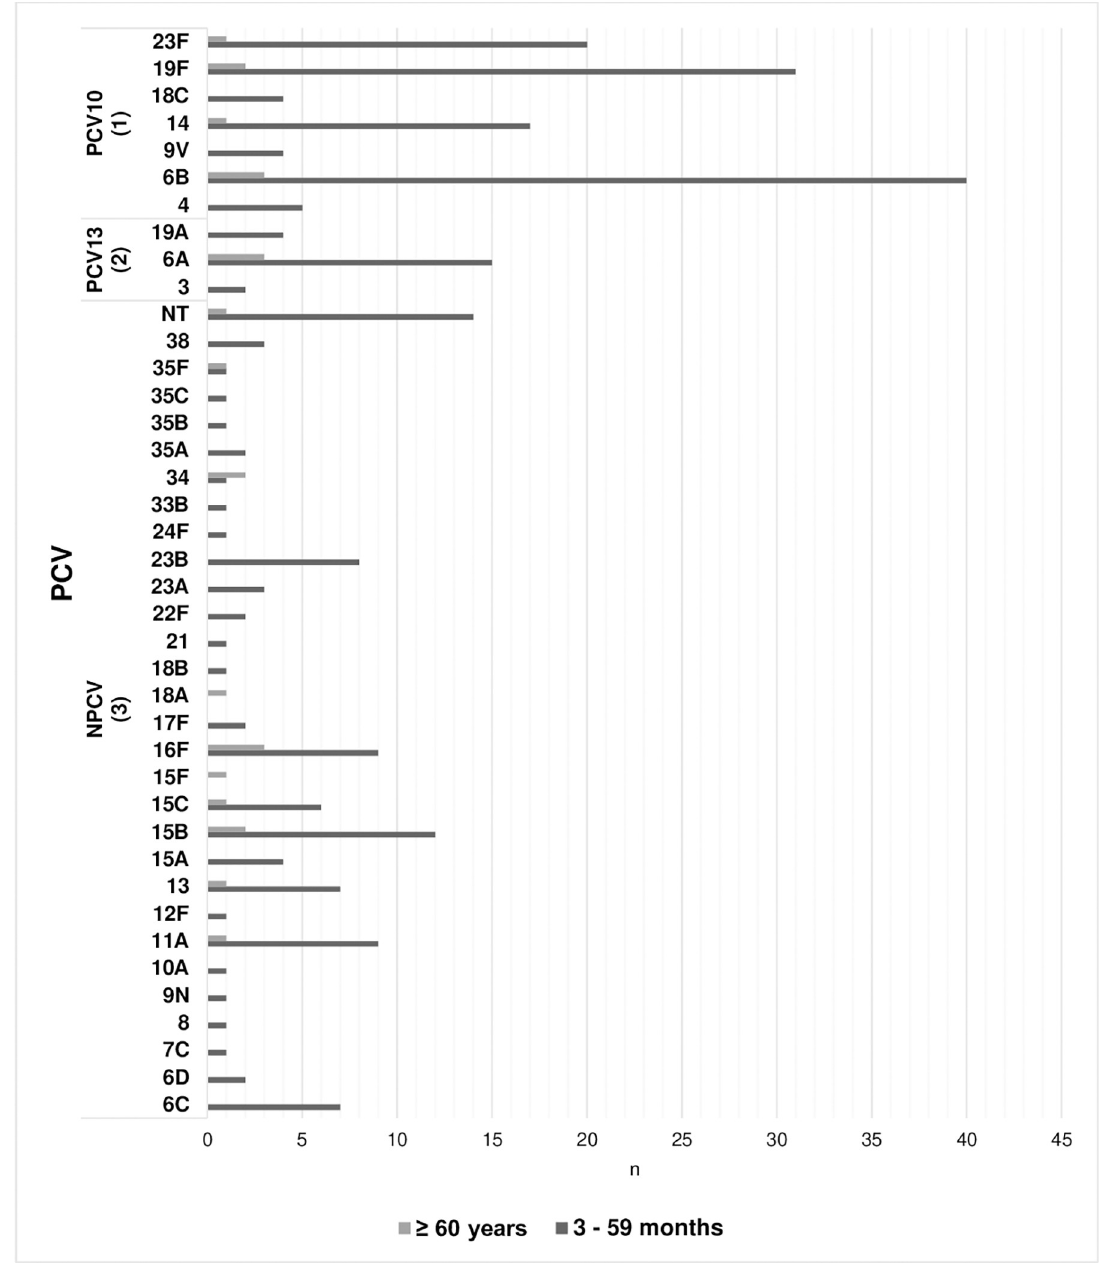
Fig 1. Distribution of pneumococcal serotypes by age group in Paraguay (n = 269). 1 PCV10: 10 valent Pneumococcal conjugate vaccine. 2 PCV13: 13 valent Pneumococcal conjugate vaccine. 3 NPCV: Serotypes not included in PCV10 and PCV13. NT: Non typeable. n: Isolates